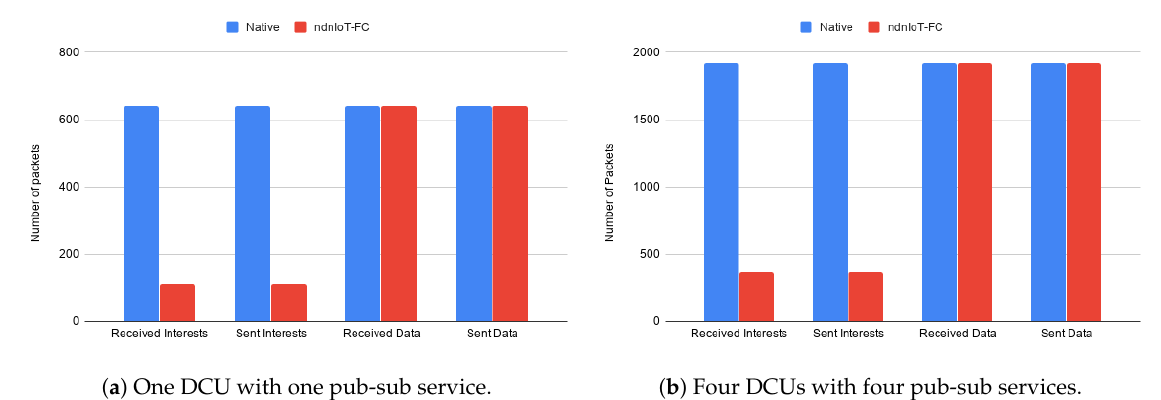
Figure 11. Use case 1: network overhead